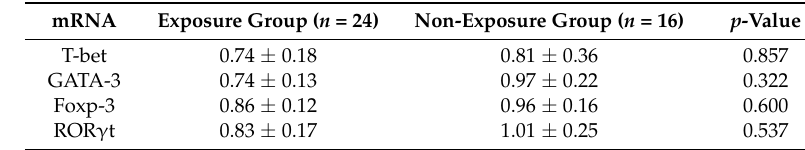
Table 3. The mRNA expression of T helper cells from patients with or without prenatal dexamethasone